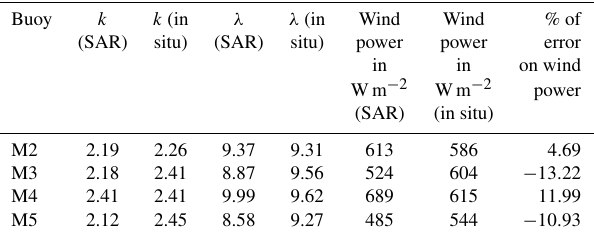
Table 9. Comparison of the long-term wind speed statistics pro- duced from the weather buoy data with those produced from the SAR data at the same locations. These values evaluate the accuracy of the satellite-derived data to provide the correct long-term average wind